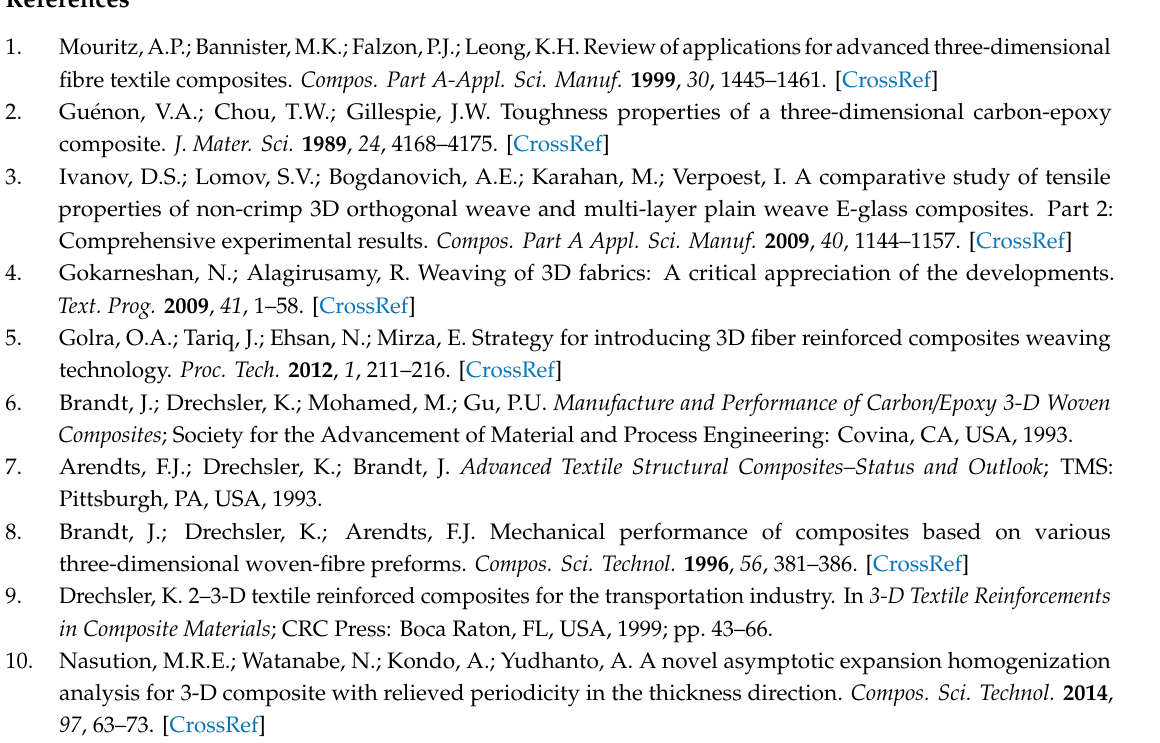
Figure S1: Structures of the 3D woven fabric: (a) 3DOW (b) 3DSSW (c) 3DSBW, Figure S2: Illustration of VARI process lay-up, Figure S3: Coupon definition and dimension for the tensile test at (a) x-, y- and (b) z-directions, Figure S4: Coupon definition and dimensions for compression test at (a) x-, y- and (b) z-directions, Figure S5: Coupon definition and dimension for flexural test at (a) x-, y- and (b) z-x, z-y directions, Figure S6: Quasi static nominal load–displacement curve for 3D woven composites under tensile test, in both (a) warp / x and (b) weft / y directions. Normal stress vs. normal strain for tensile test in (c) warp / x and (d) weft / y directions, Figure S7: (a) Quasi static nominal load–displacement curve for 3D woven composites in the z- direction tensile test. (b) Normal stress vs. normal strain for tensile test in z direction, Figure S8: Quasi static nominal load–displacement curve for 3D woven composites under compressive test, in both (a) warp / x and (b) weft / y directions. Normal stress vs. normal strain for compressive test in (c) warp / x and (d) weft / y directions, Figure S9: (a) Quasi static nominal load–displacement curve for 3D woven composites in the z- direction compressive test. (b) Normal stress vs. normal strain for compressive test in z direction, Figure S10: Quasi static nominal load–displacement curve for 3D woven composites under flexural test, in both (a) warp / x and (b) weft / y directions. Normal stress vs. normal strain for flexural test in (c) warp / x and (d) weft / y directions, Figure S11: Illustration of yarn pattern in (a) the z-x directional coupon and (b) the z-y directional coupon, Figure S12: Quasi static nominal load–displacement curve for 3D woven composites under flexural test, in both (a) the z-x and (b) z-y directions. Normal stress vs. normal strain for flexural test in (c) z-x and (d) z-y directions, Table S1: The properties of T800 carbon fiber, Table S2: The properties of epoxy resin BAC172, Table S3: The thickness of unit cell in 3D woven composite, Table S4: The measurement data for fiber waviness, Table S5: Engineering constants obtained for in-plane loading and out-plane tension, Table S6: Engineering constants obtained for in-plane loading and out-plane compression, Table S7: Engineering constants obtained for in-plane loading and out-plane